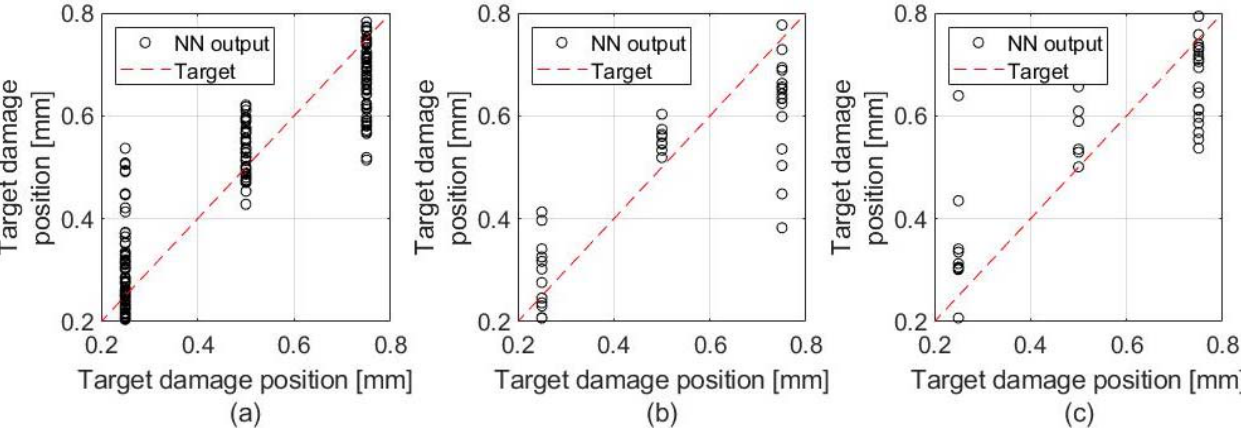
Figure 22. Localization ANN performances for the ( a ) training, ( b ) validation, and ( c ) test subsets (entire database).